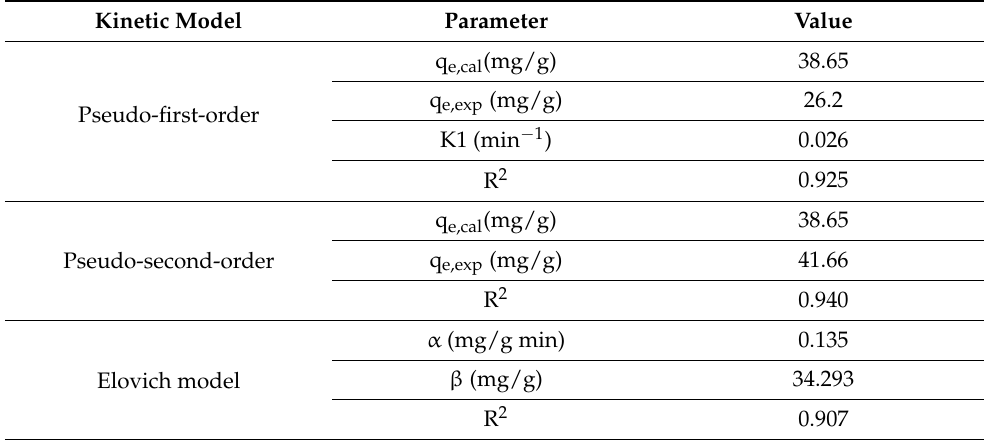
Table 2. Kinetic model adsorption variables for the adsorption of As(V) on the BT-An@Zetag composite.